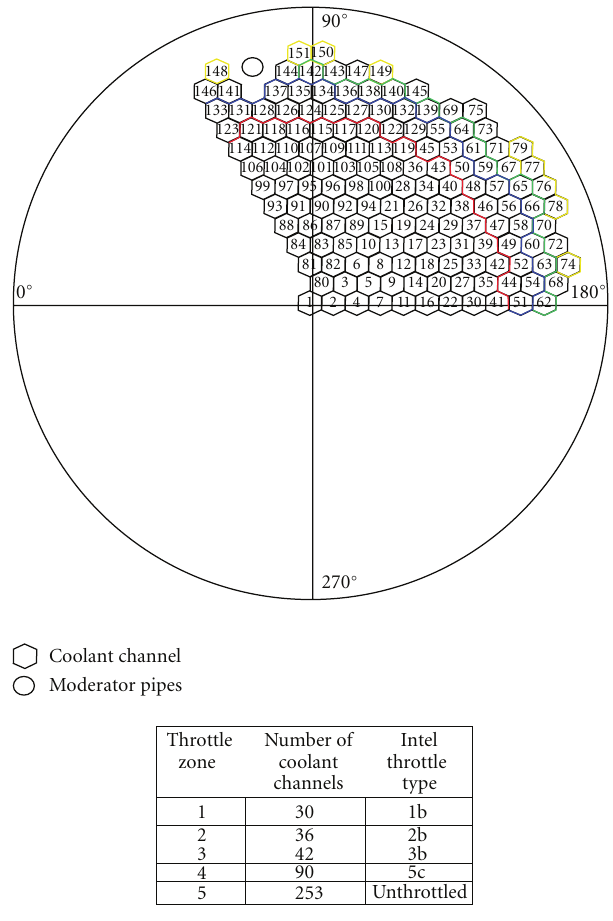
Figure 2: CNA-2 thermohydraulic